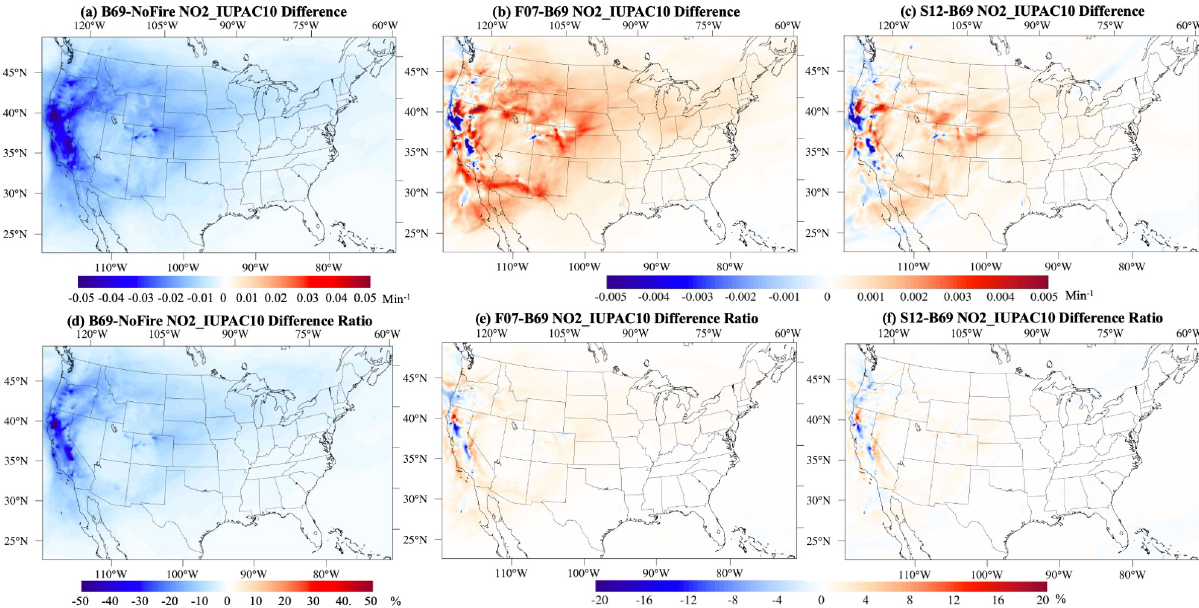
Figure 9. The average photolysis rate NO2_IUPAC10 differences between B69 and NoFire (a) , between F07 and B69 (b) , and between S12 and B69 (c) from 1 August to 30 September 2020. The average photolysis rate NO2_IUPAC10 difference ratio between B69 and NoFire (d) , between F07 and B69 (e) , and between S12 and B69 (f) during the same period.